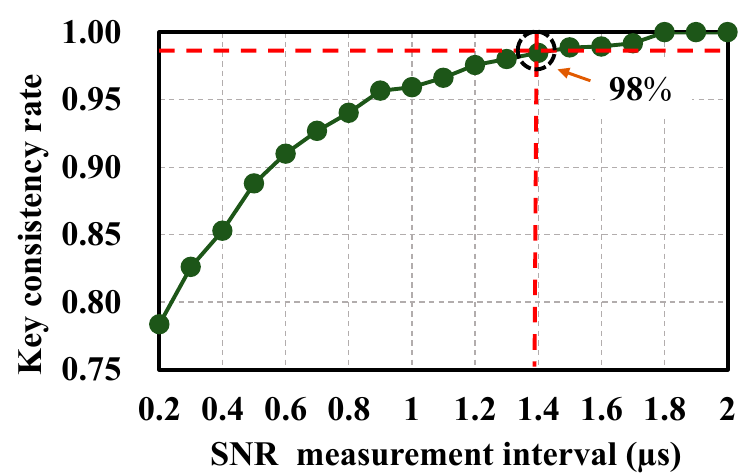
Figure 7. Influence of SNR measurement interval on Alice–Bob consistency.